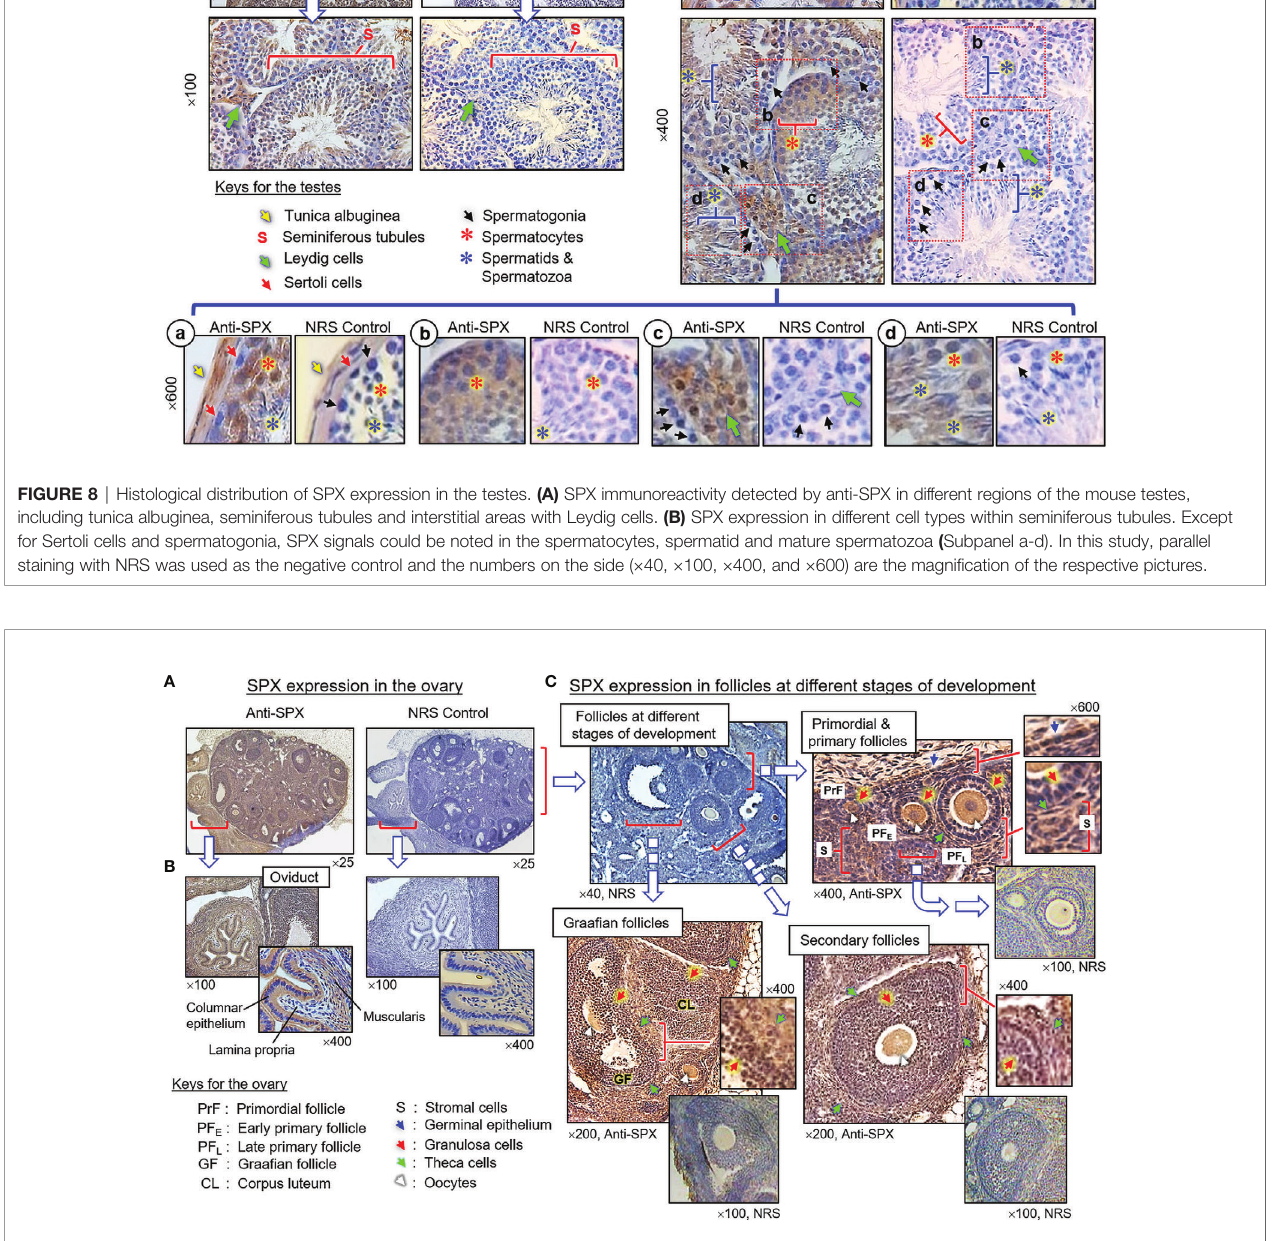
FIGURE 9 | Histological distribution of SPX expression in the ovary. (A) SPX immunoreactivity detected by anti-SPX in the mouse ovary and oviduct. (B) SPX expression in the oviduct. SPX signals were located in columnar epithelium and muscularis layer but not in the lamina propria of the oviduct. (C) SPX expression in different cell types within the ovary. SPX immunostaining could be noted in the germinal epithelium, stromal cells, and various cell types (including the oocytes, granulosa cells and theca cells) within the follicles at different stages of development. In this study, parallel staining with NRS was used as the negative control and the numbers shown on the top/below individual panels (×40, ×100, ×200, ×400, and ×600) represent the magni fi cation of the respective